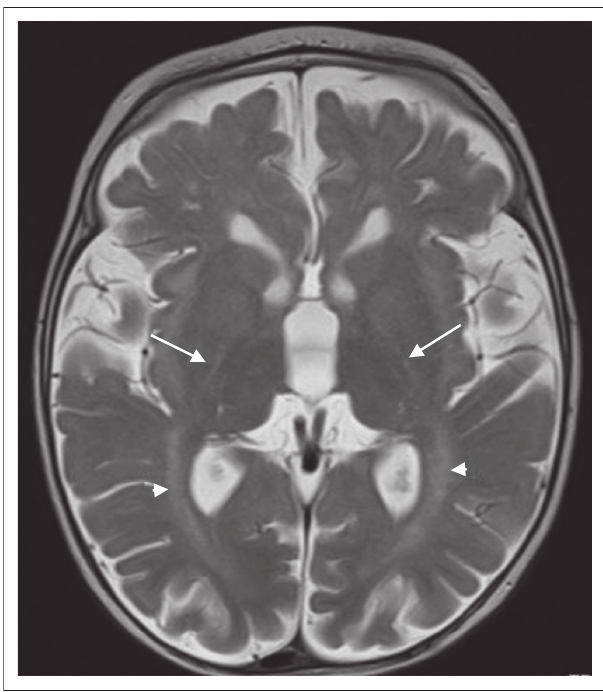
FIGURE 6: T2 axial image of patient 2. Increased signal intensities in the periventricular white matter (arrowheads) and internal capsules (arrows) bilaterally. There is associated diffuse cortical